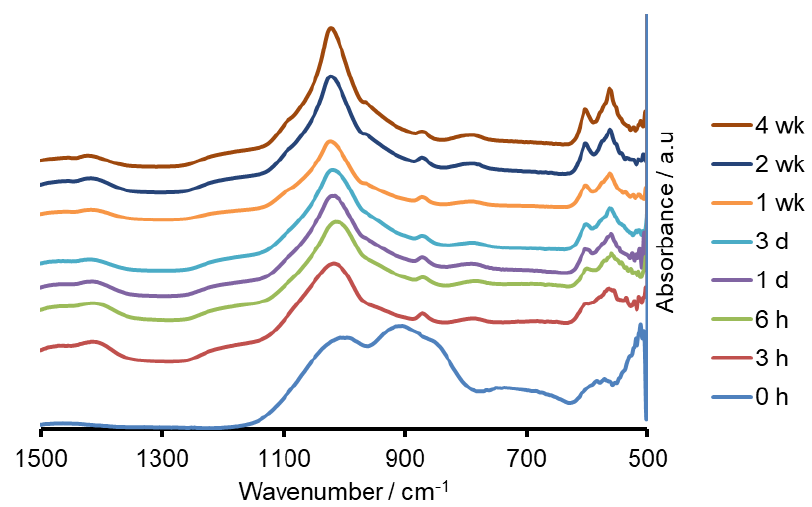
Figure 3. FTIR spectra of Na-FBAG before and after immersion.